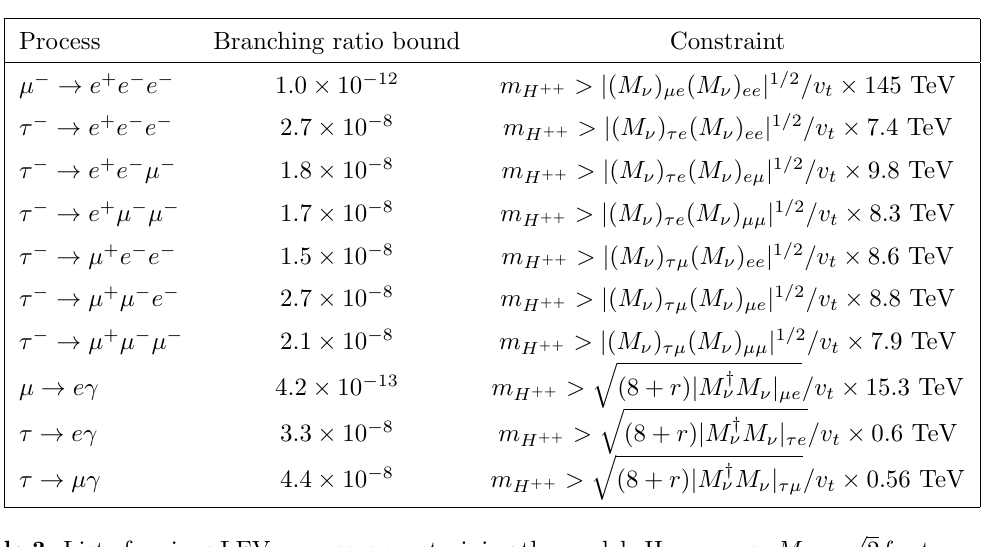
Table 3 . List of various LFV processes constraining the model. Here we use M (cid:23) = Yukawa couplings f ab in terms of neutrino mass matrix elements. We also de(cid:12)ne r (cid:17) m 2 All bounds are taken from ref.